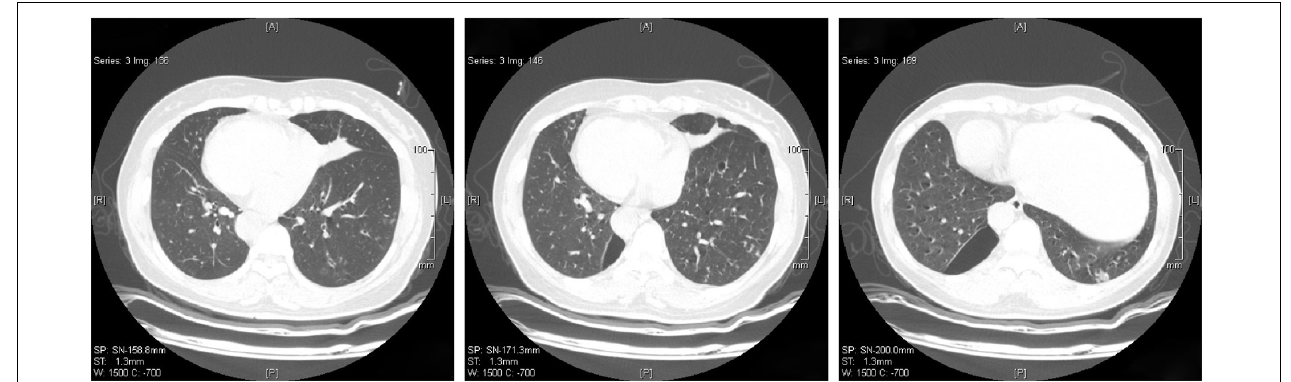
FIGURE 2 | Chest computed tomography shows inflammation in both sides of lung lobes.